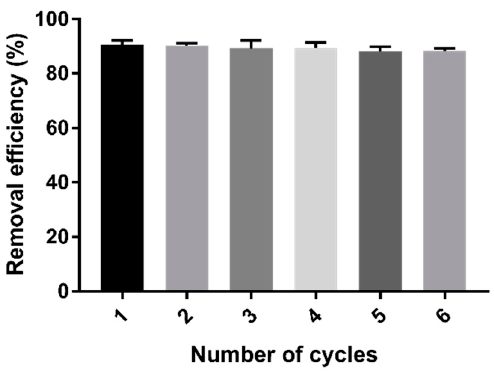
Figure 10. Changes in the removal efficiency of Cd (II) after six cycles of adsorption–desorption process.